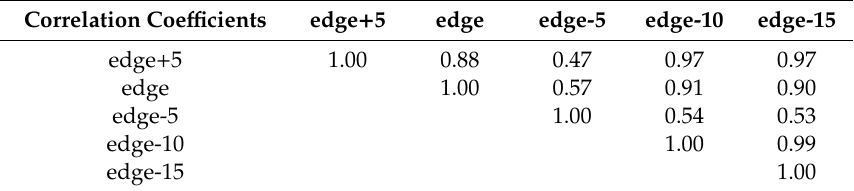
Table 2. Correlation coe ffi cients between signals listed in Figure